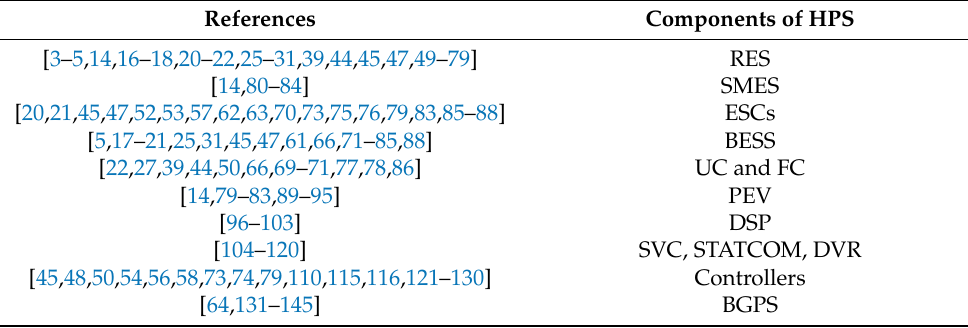
Figure 1. The overall distribution of literature as per components of HPS. Table 1. Components of HPS reported in the